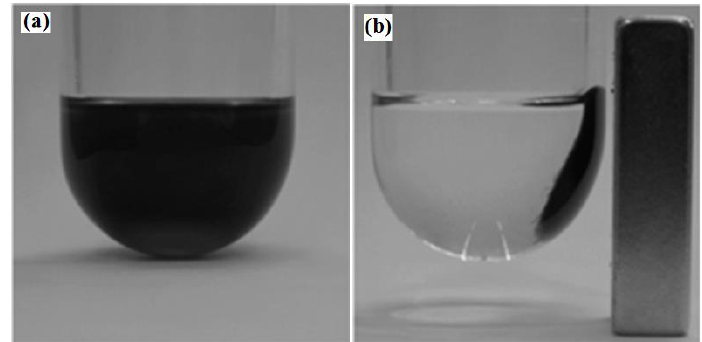
Fig. 1. Magnetic nanoadsorbent separation in Co(II) ions media (a) before using magnet, Fig. 1 (b) after using magnet